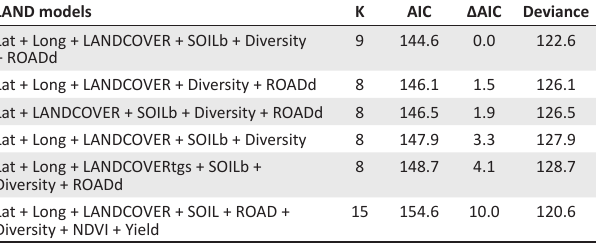
TABLE 2: Output of generalised linear mixed model selection comparing nesting success of Southern Ground-hornbills. LAND models